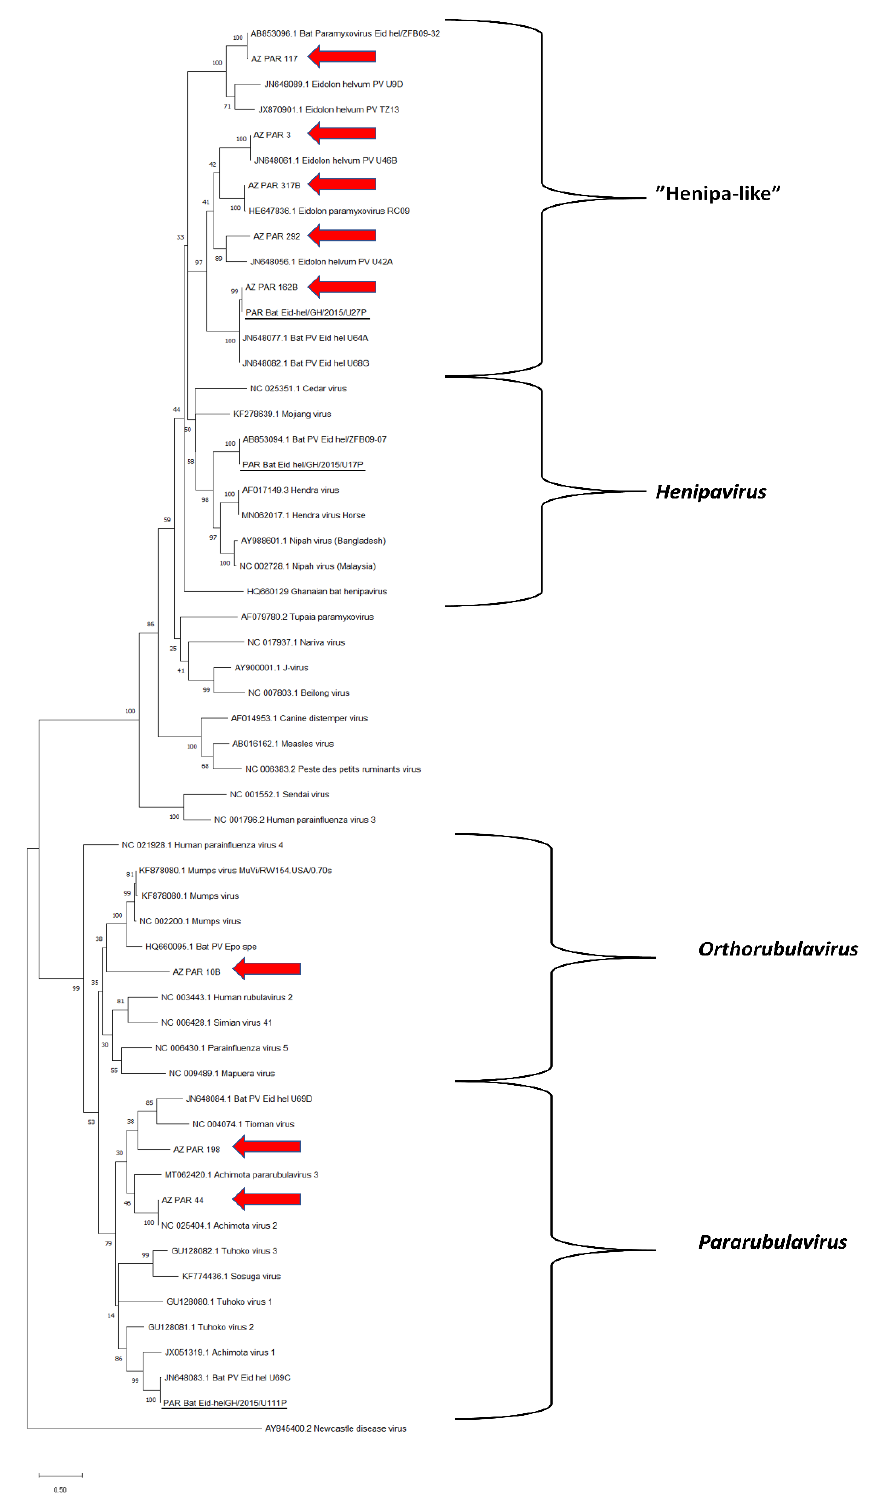
Figure 2. Maximum likelihood tree for sequences detected in the PCR using general paramyxovirus primers (PAR). The tree was rooted to the branch of Newcastle disease virus. The 2019 sequences from the research colony are highlighted with red arrows, and 2015 sequences reported by Gibson et al. [23] are underlined. All other sequences originate from the NCBI database. Bootstrap values for 1000 replicates are indicated as percentages, and nucleotide substitutions per site are to scale as indicated by the scale bar.